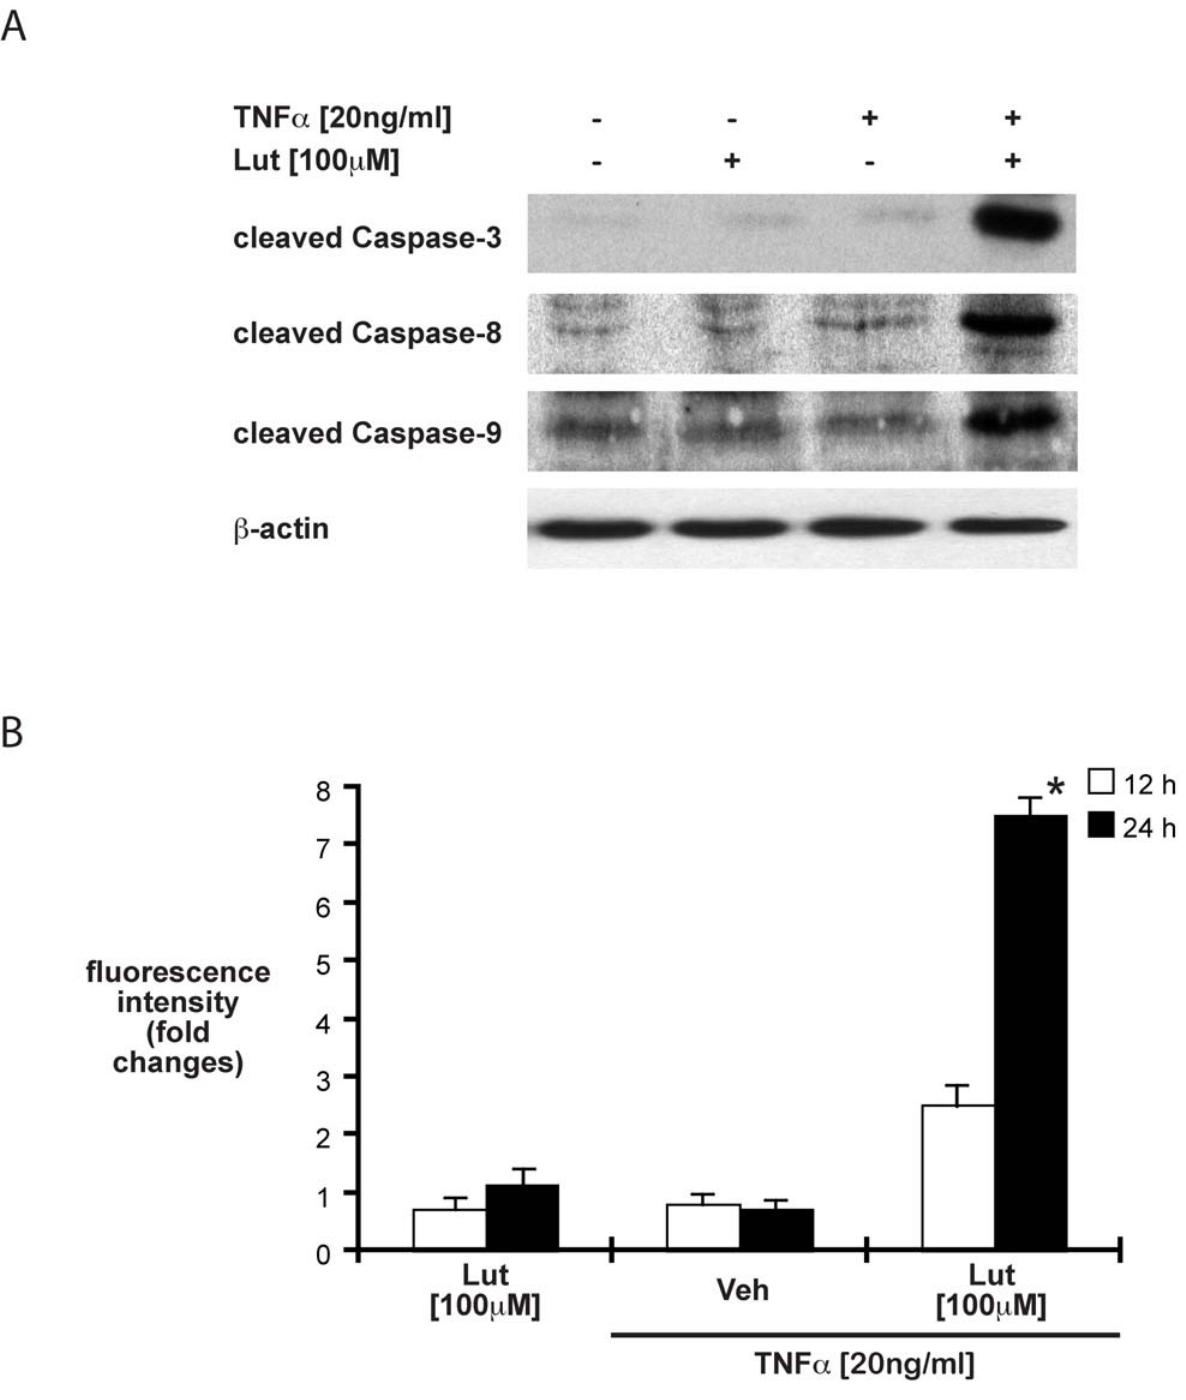
Figure 7. Luteolin-treatment induces caspase 3, 8 and 9 activation in the presence of TNF a in HT29 cells. HT29 cells were treated with luteolin (100 m M) alone or in combination with TNF a (20 ng/ml) for 12 h. Cells were lysed, protein extracts (20 m g) were subjected to SDS-PAGE (13%) and caspase 3, 8 and 9 processing was evaluated by Western blot using specific antibodies for cleaved caspases 3, 8 and 9. Immunoreactive proteins were detected using the enhanced chemiluminescence (ECL) technique. Representative results of at least 3 independent experiments are shown (A). Cells were treated as described above for 12 and 24 h. Cells were lysed and caspase 3 activity was quantified using a fluorescence-based assay as described in the Method section. Representative results of at least 3 independent experiments are shown (* p , 0.01 versus TNF a alone at 24 h)